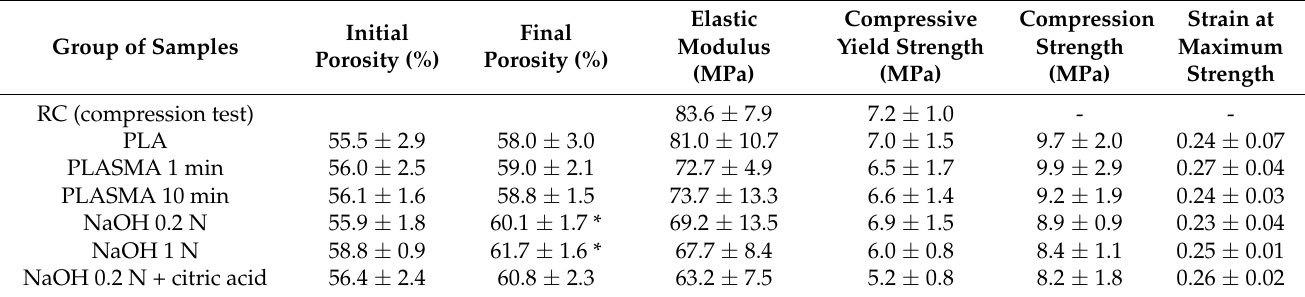
Table 3. Porosity values (before and after the degradation test) and compression test results.